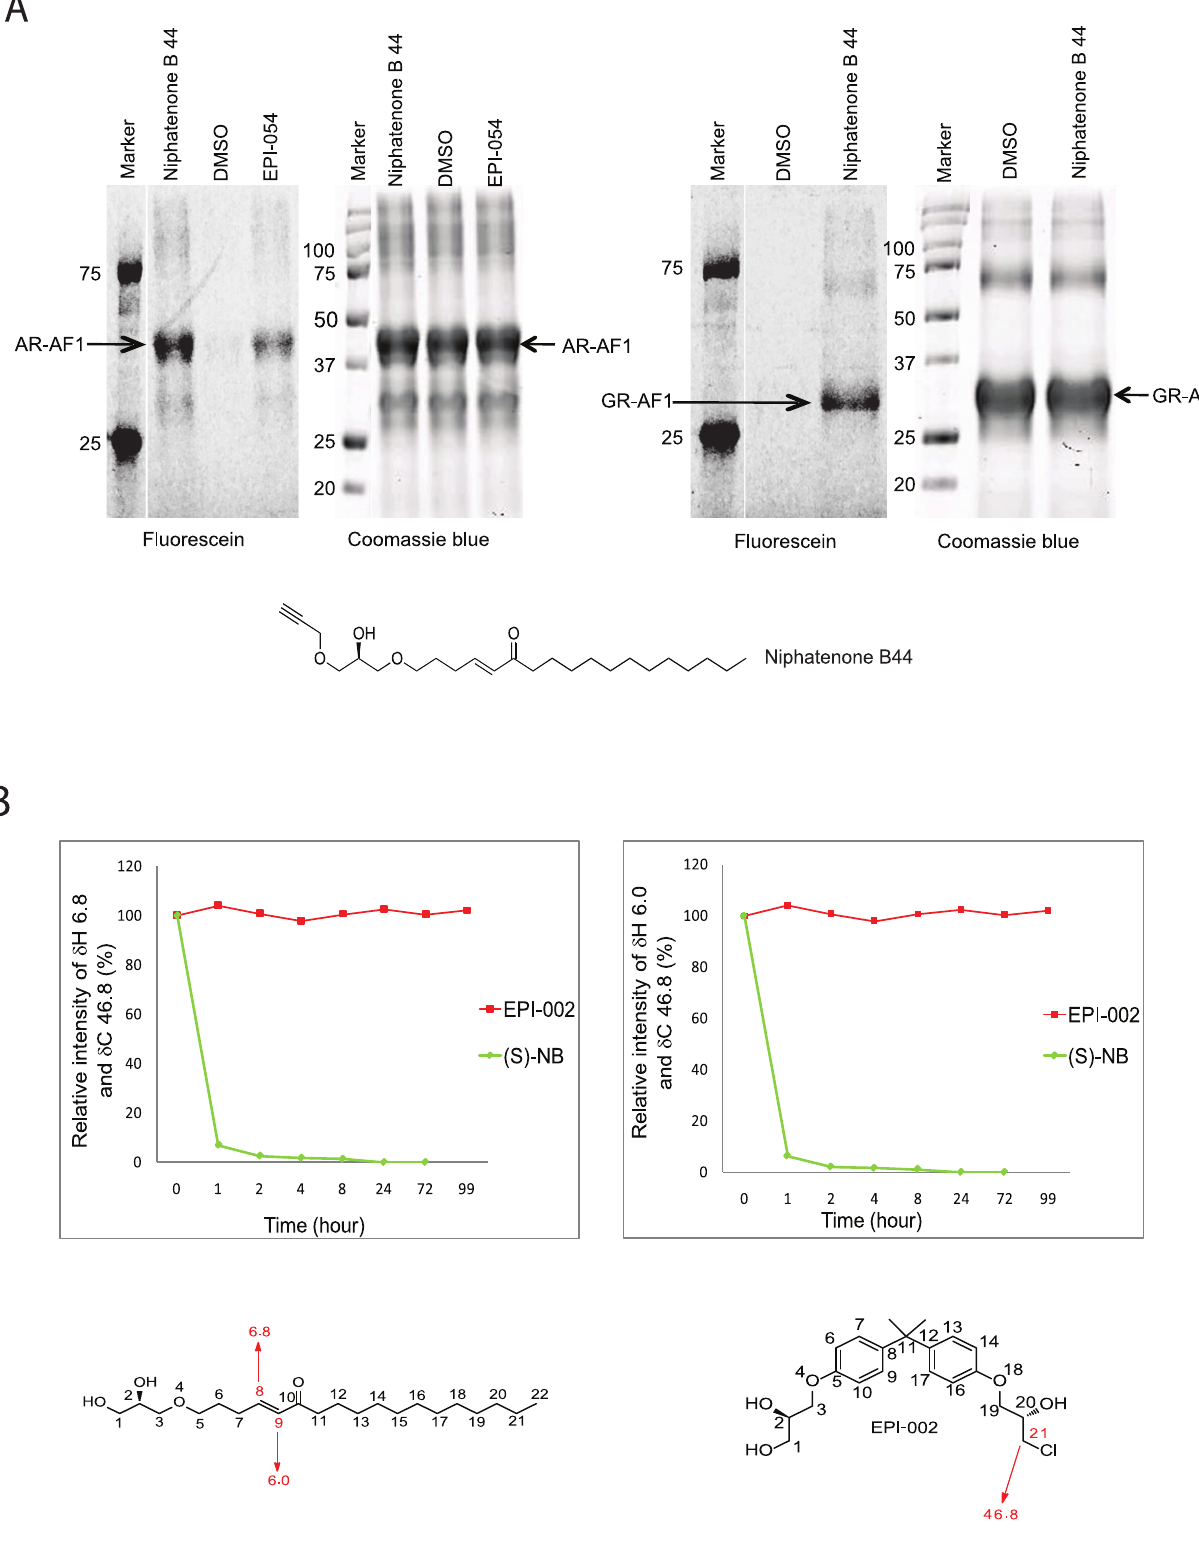
Figure 4. Niphatenone B covalently binds both AR AF-1 and GR AF-1. (A) AR AF-1 and GR AF-1 peptides were incubated with DMSO (vehicle), niphatenone B 44 (structure shown at bottom of the) or EPI-054 for 45 minutes prior to Click-chemistry to add a fluorescein moiety to the probe. Fluorescein-labeled probes covalently bound to the AF-1 peptides were detected with reducing SDS-PAGE. Total protein in each of the lanes was shown by Coomassie blue staining of the gel. (B) Niphatenone alkylates glutathione. A mixture of glutathione (0.07 mmol), ( S )-niphatenone (0.014 mmol), EPI-002 (0.014 mmol) was monitored by NMR after 1, 2, 4, 8, 24, 72 and 99 hours. Proton 8 and 9 integral values were used as a reference for niphatenone and carbon 21 integral value was used a reference for EPI-002. See Tables 1 and 2. doi:10.1371/journal.pone.0107991.g004 PLOS ONE |